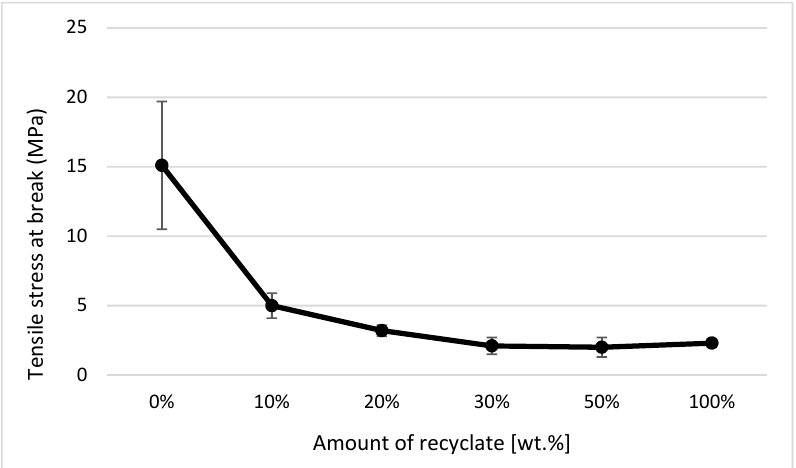
Figure 15. Dependence of stress at the break point on the proportion of weight of the recycled material after exposure of samples to elevated temperature.